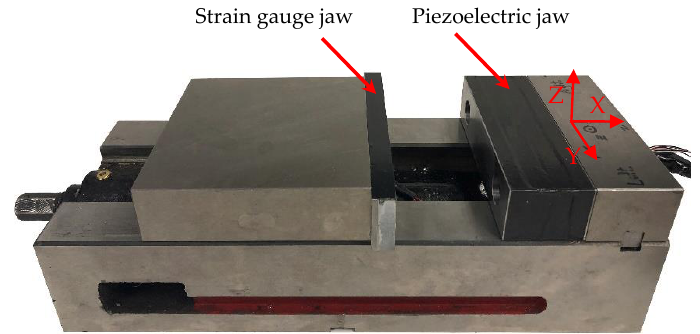
Figure 8. Jaws with embedded strain gauges and piezoelectric sensors.